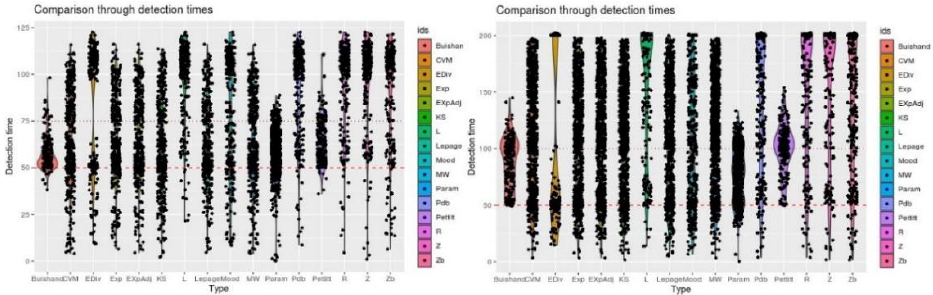
Fig. 5. Change identification under λ 0 : 1 → 2,β : 3.8 → 0.8: left panel - failure truncation, right panel - time